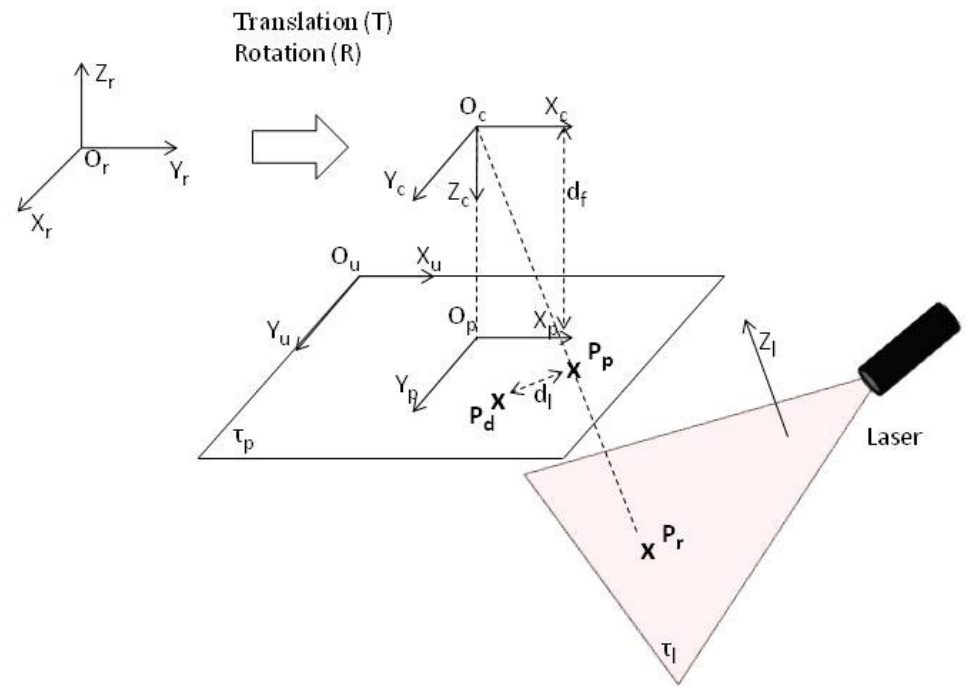
Figure 7. Diagram representing camera and world coordinates for laser plane calibration in the general